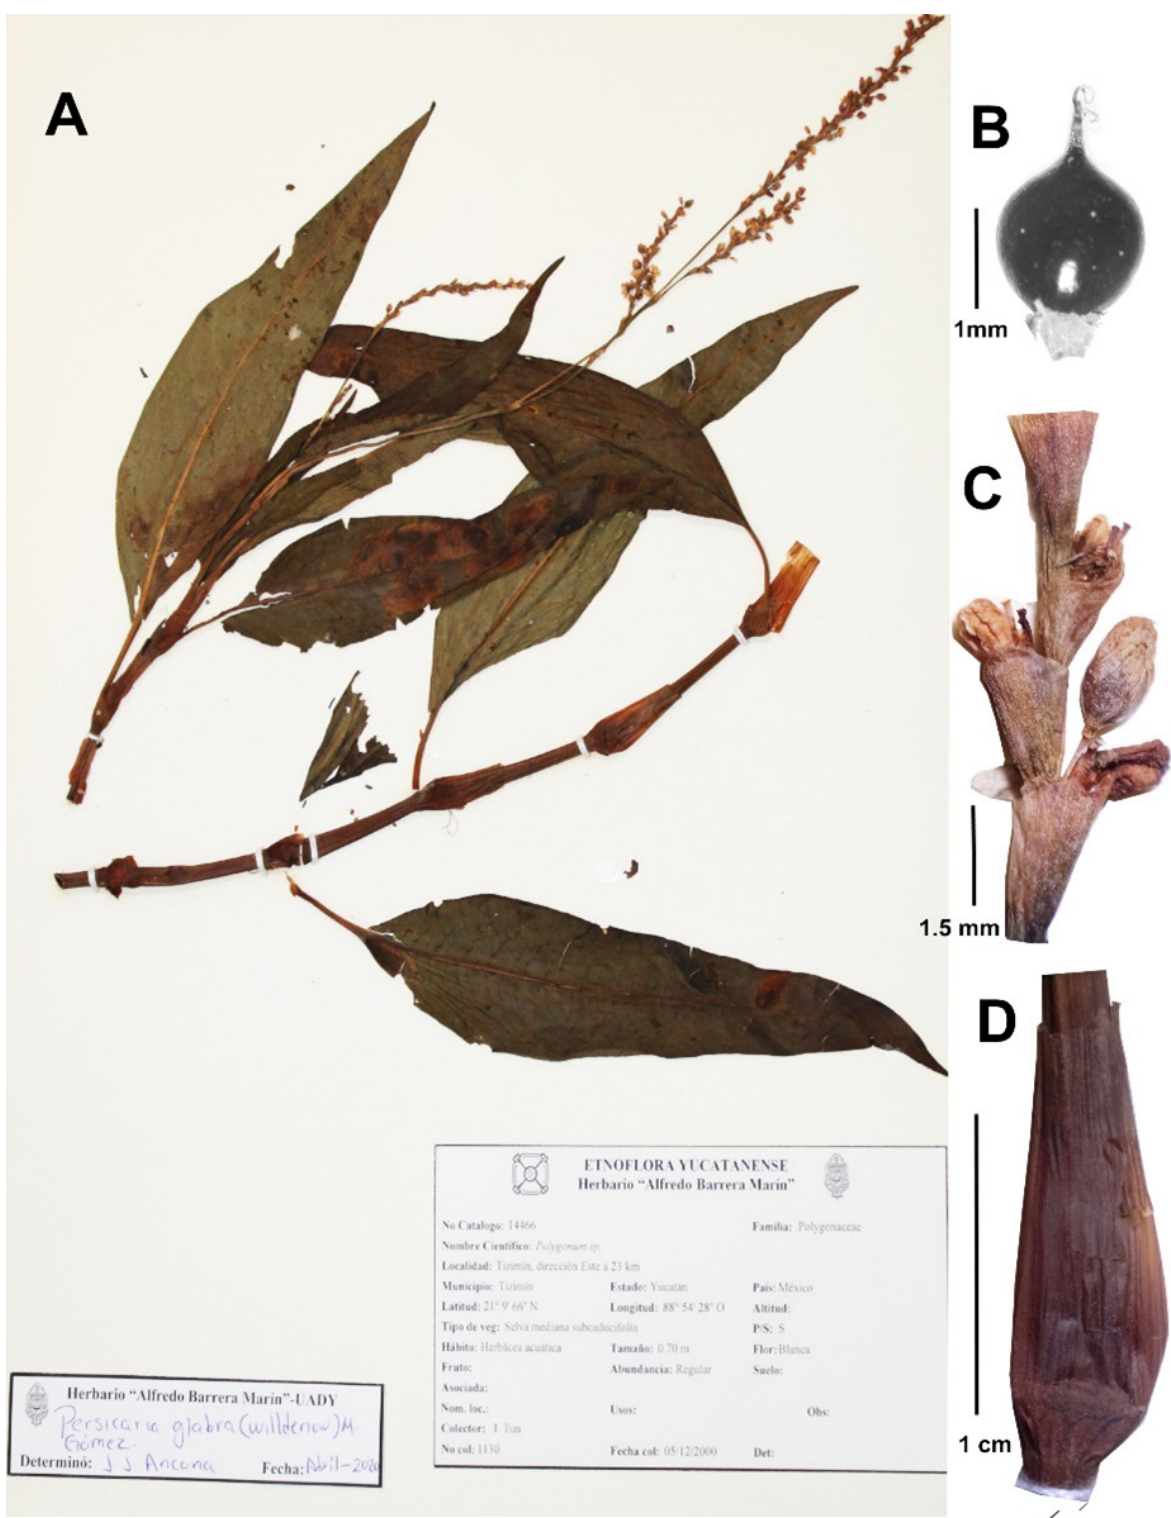
Figure 3. Persicaria glabra. A . Specimen J. Tun 1130 (UADY). B. Biconvex achene, with two styles. C. Inflorescence details: ochreolae gla- brous, eciliate; perianth accrescent glandular-punctate. D. Ochrea glandular-punctate, glabrous,